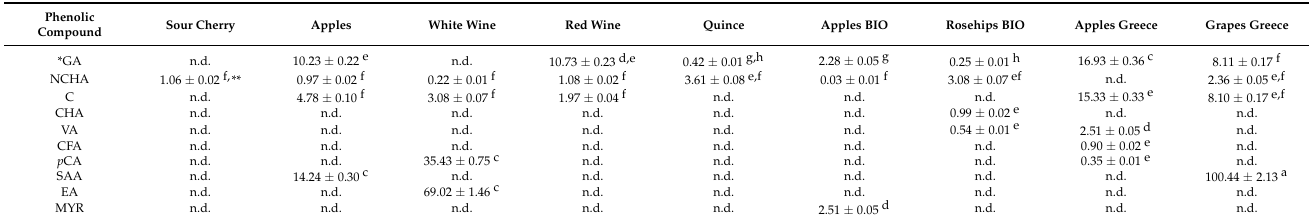
Table 3. Phenolic compounds content (mg L − 1 ) of the commercial